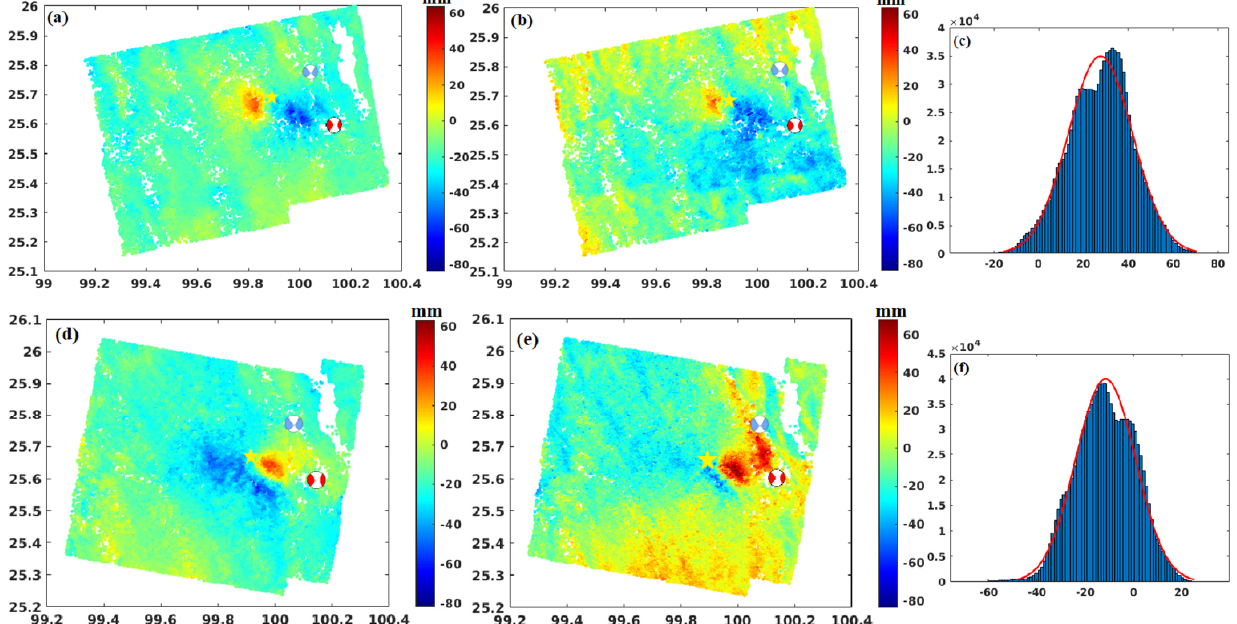
Figure 4. LOS coseismic deformation displacement: ( a , d ) represent the LOS coseismic deformation displacements in the ascending and descending tracks extracted by time–series InSAR, respectively; ( b , e ) represent the LOS coseismic deformation displacements in the ascending and descending tracks extracted by D–InSAR, respectively; and ( c , f ) represent the frequency distribution histograms of the LOS deformation differences in the ascending and descending tracks, respectively.